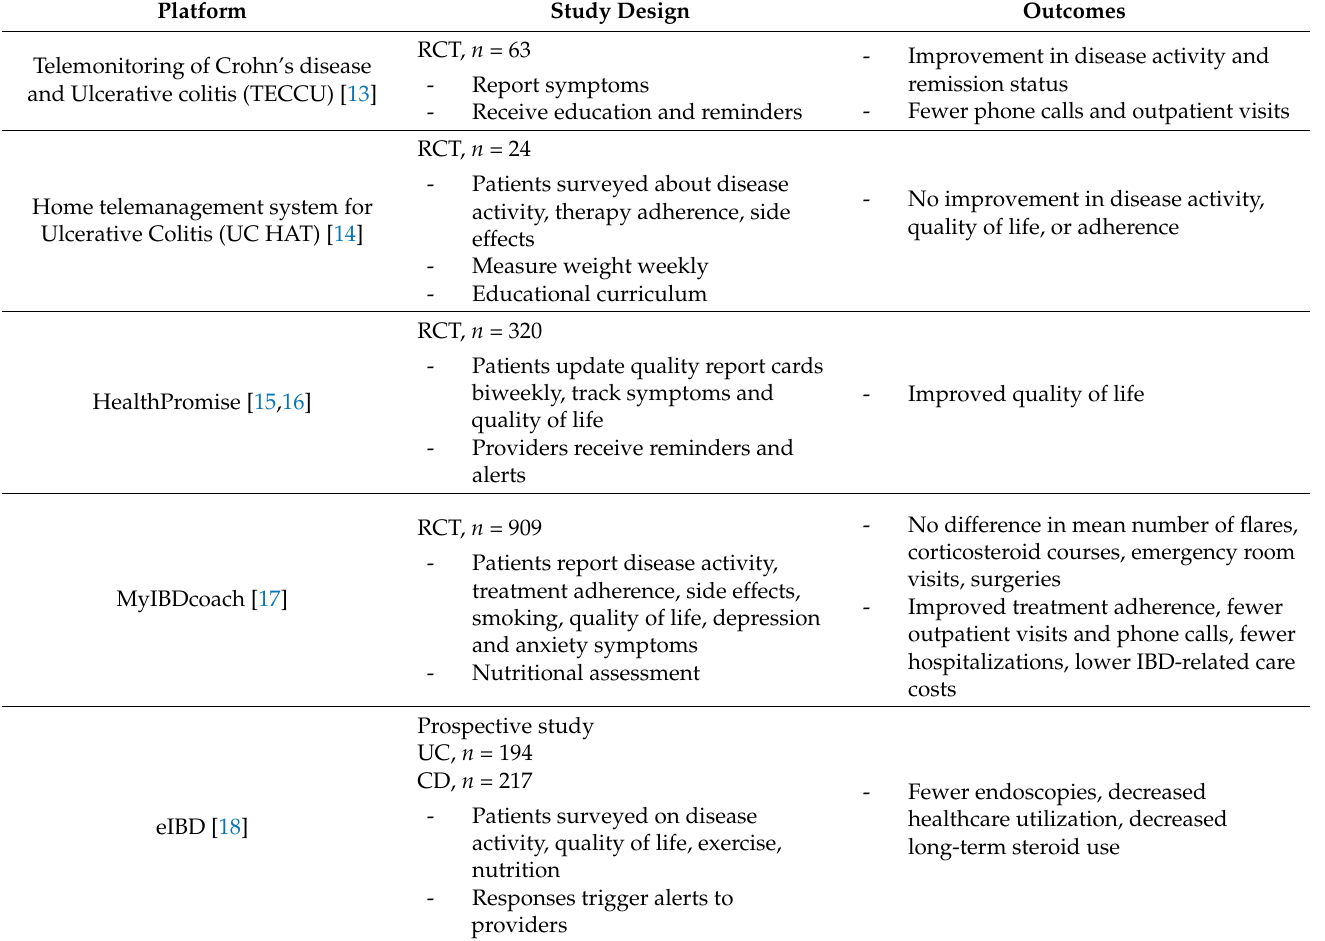
Table 1. Clinical Studies on IBD Remote Monitoring and